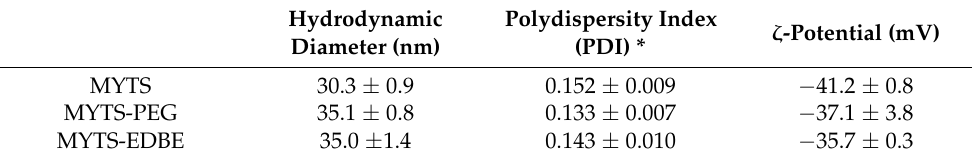
Figure 1. NPs characterization. ( A ) TEM Image and particle size distribution of PMDA-coated iron oxide nanoparticles; ( B ) MYTS, MYTS-PEG and MYTS-EDBE number size distribution as detected by DLS analysis ( n = 3). Table 1. DLS and ζ -Potential analyses of MYTS, MYTS-EDBE, MYTS-PEG. The hydrodynamic diameter was obtained by number size distribution. Data represent mean ± SD of three independent